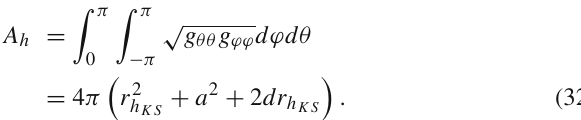
Fig. 1 V ω lm as a function of r , for different values of the KS black hole normalized charge (top panel) and different values of the KS black hole angular momentum (bottom panel). For both panels we have chosen l = m = 1 and M ω = 0 . 1